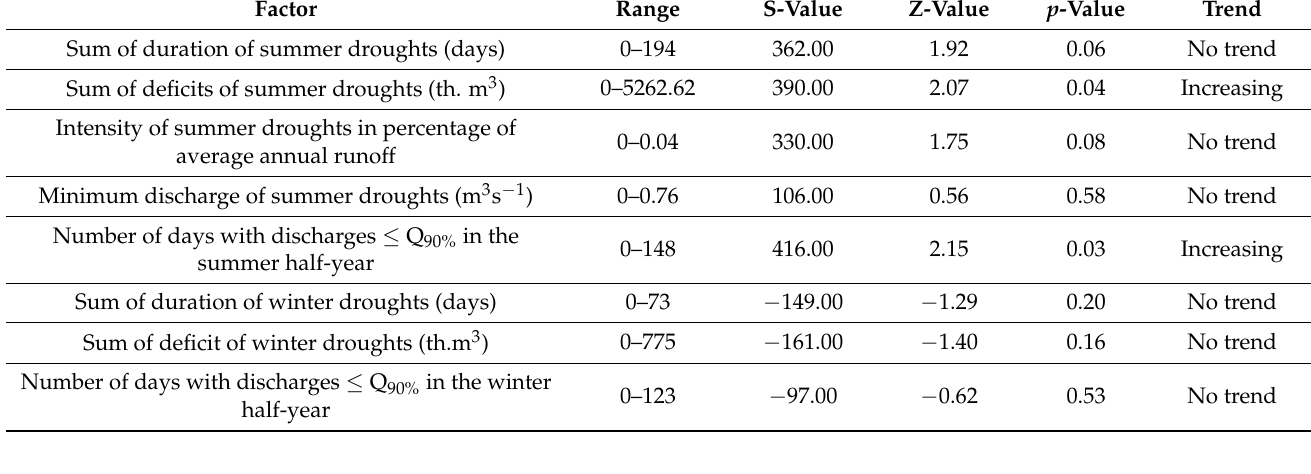
Table 3. A summary of the Mann–Kendall test statistics for the selected hydrological drought factors at 95% confidence level. S, Z = statistics of the Mann–Kendall test; p = significance level; h.y. = hydrological year. The number of annual values in the calculation is 70.